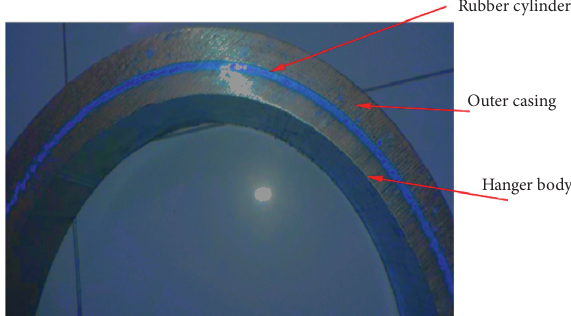
Figure 22: Rubber cylinder is completely squeezed between the hanger body and the outer